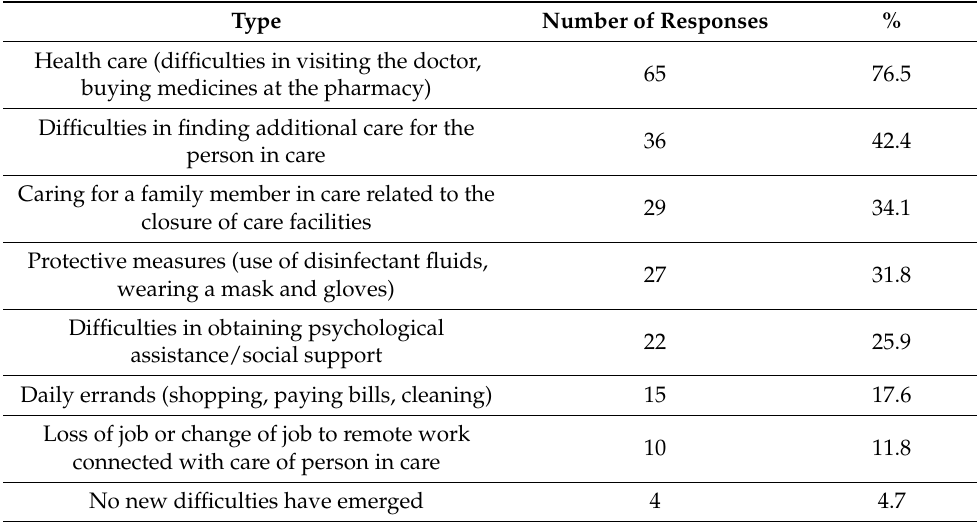
Table 2. Covid-19-related problems of caregivers in the daily care of AD charges.